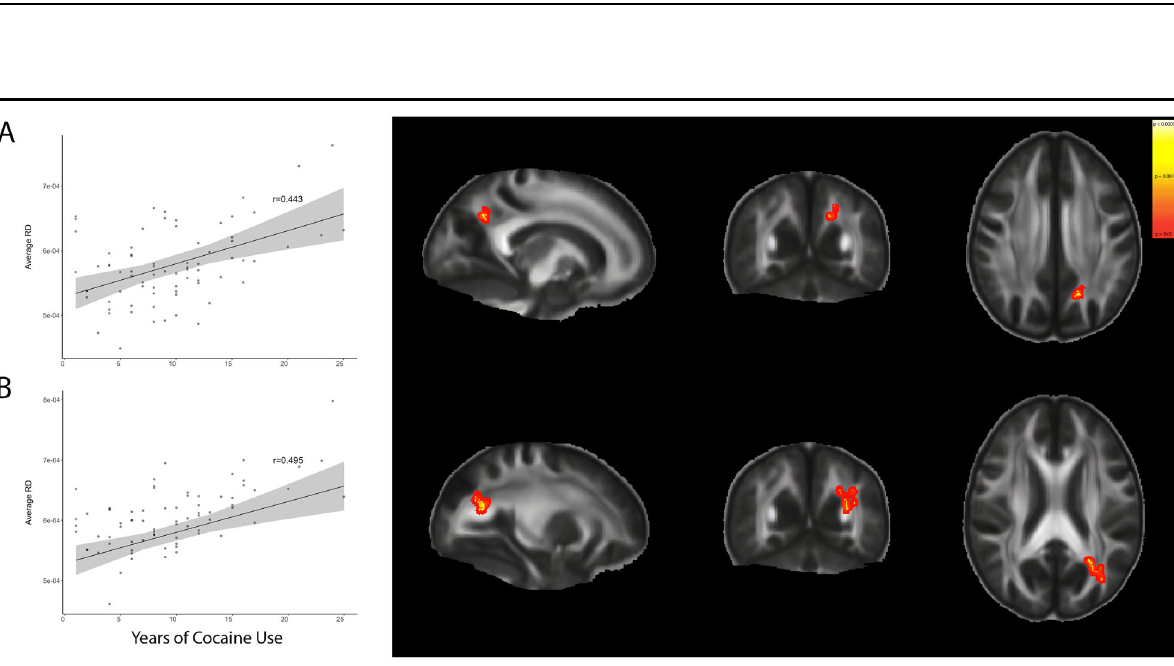
Fig. 3 Clusters with a strong positive association between RD and years of crack-cocaine use. A Included regions of anterior thalamic radiation, cingulum, inferior fronto-occipital fasciculus, inferior longitudinal fasciculus, and superior longitudinal fasciculus. MNI coordinates are as follows: x = 106, y = 65, z = 107. B Included regions of anterior thalamic radiation, cingulum (cingulate gyrus), cingulum (hippocampus), forceps major; inferior fronto-occipital fasciculus, inferior longitudinal fasciculus, and superior longitudinal fasciculus. MNI coordinates are as follows: x = 117, y = 65, z = 95. RD radial